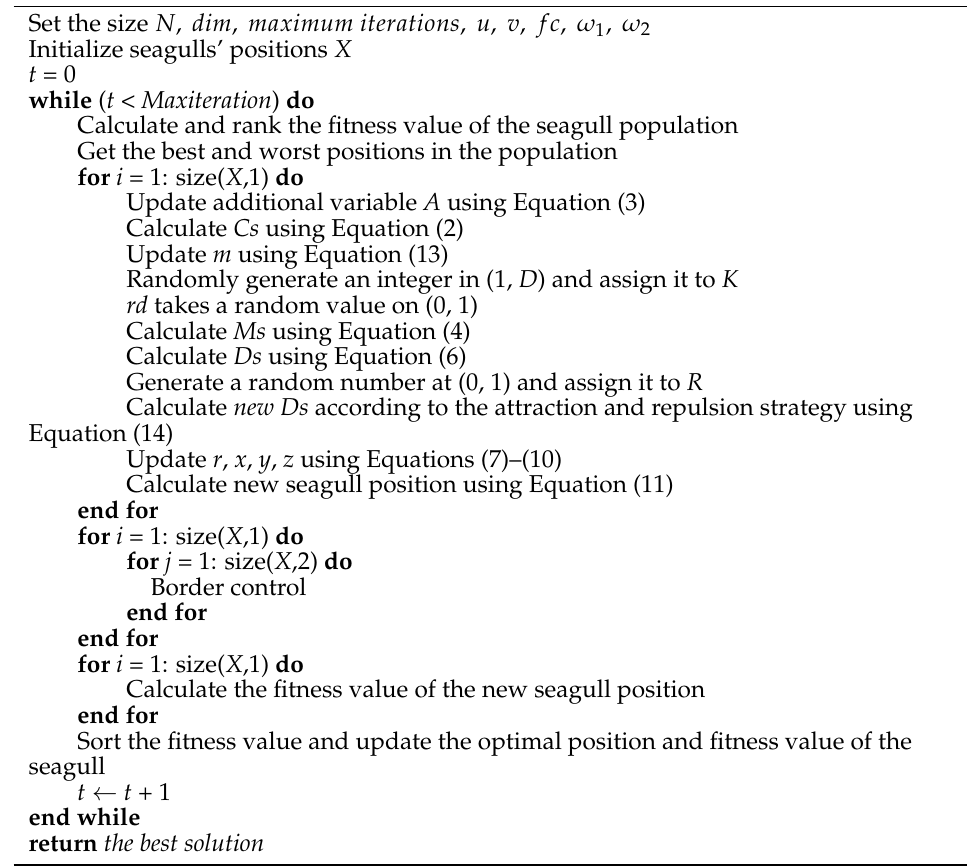
Figure 1. Flow chart of IDARSOA. Algorithm 2. Pseudocode of